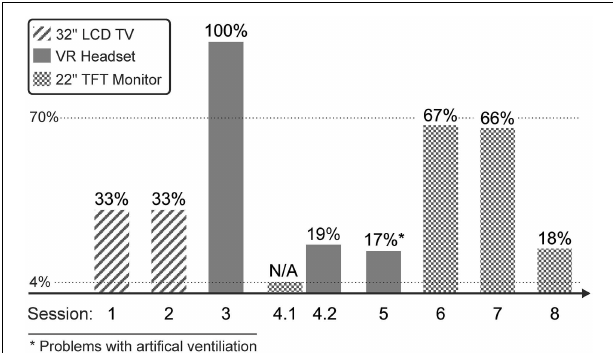
FIGURE 4 | Average accuracies achieved by the participants with LIS during online spelling in individual sessions. Please note that the letters spelled varied between 15 and 29 for individual sessions. In session 4.1 no online spelling was performed with the 22” monitor due to the low classification accuracy achieved with the screening runs (see Section Remarks of Users Concerning the Usability of the Display Methods).The first dotted horizontal line indicates the chance level (4%) and the second horizontal line the threshold level that has been defined for satisfactory communication (70%).